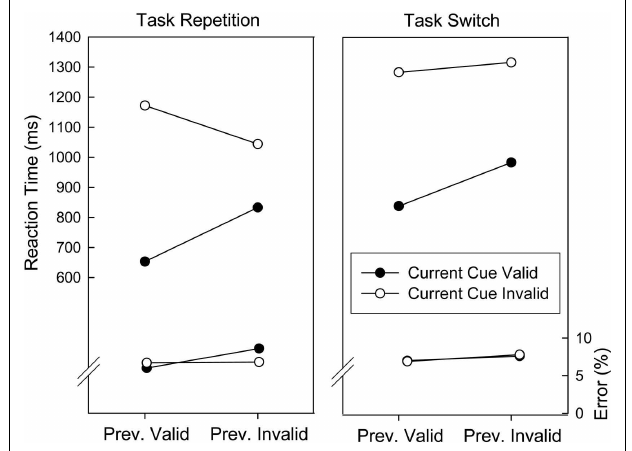
FIGURE 3 | Mean reaction times and error proportions of Experiment 2 as a function of cuing validity of the current and preceding trials and task